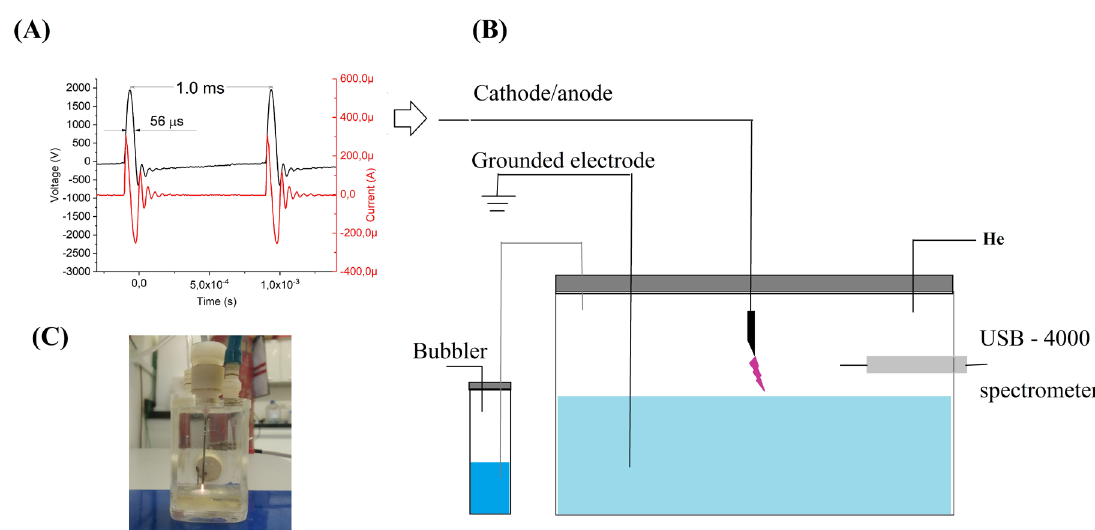
Figure 1. (A) The measured current and voltage time dependence of the discharge; (B) Experimental apparatus used in this work showing detail of reactor and bubbler; (C) Reactor during plasma treatment.